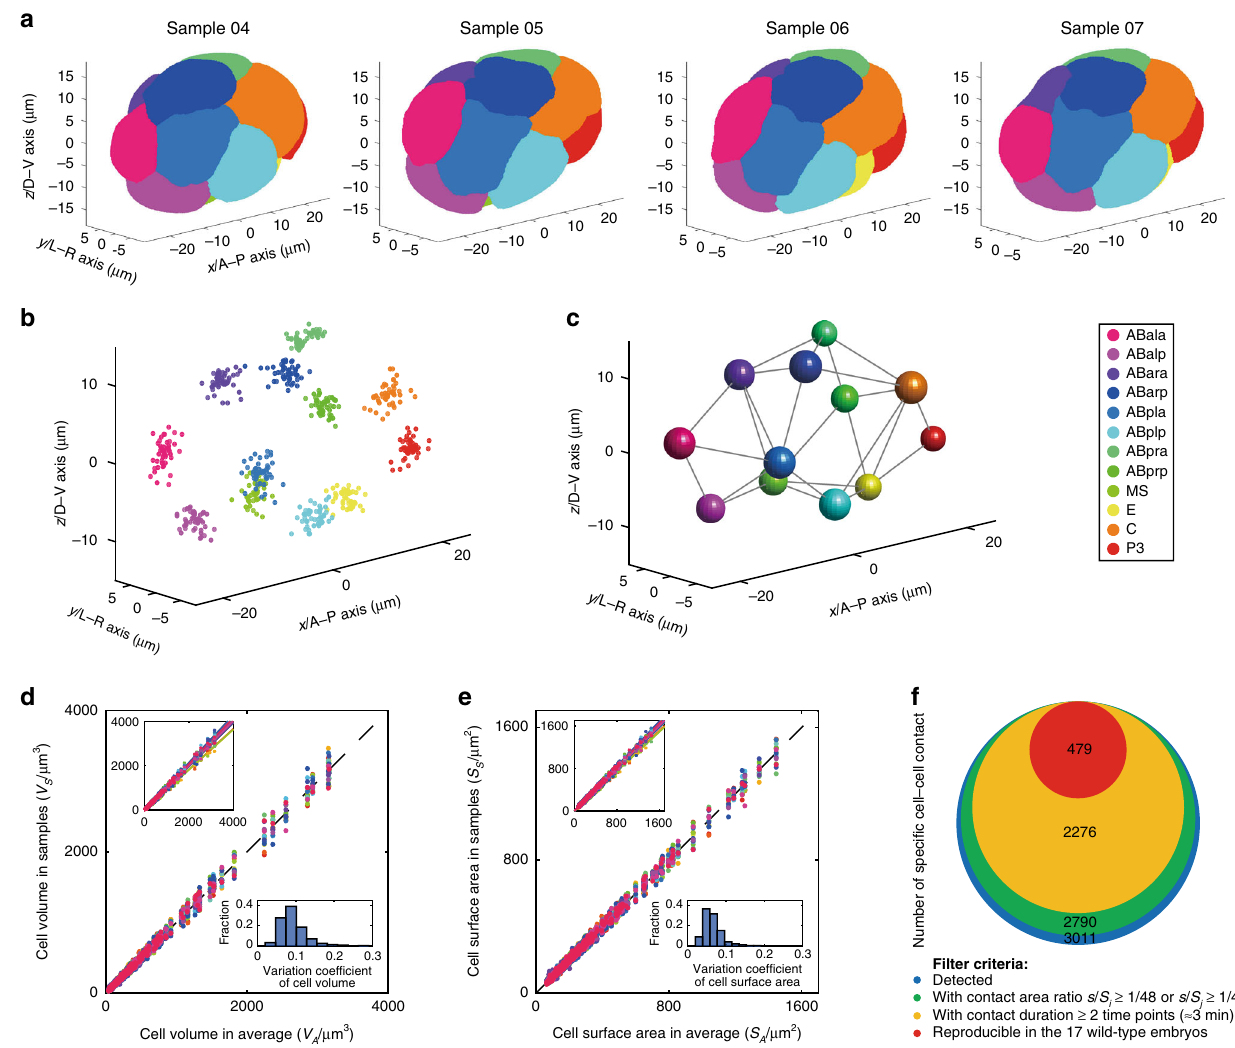
Fig. 3 A morphological atlas during C. elegans embryogenesis. a – c Different dimensions of a standardized spatiotemporal reference, illustrated using the 12-cell stage as an example. The x, y , and z axes represent the anterior – posterior (A – P), left – right (L – R), and dorsal – ventral (D – V) axes, respectively, and each color denotes one speci fi c blast cell as indicated. a 3D representations of four wild-type embryos reconstructed with membrane label (Samples 04 – 07). b Spatial distribution of cell position (nuclei) of 46 embryos (Samples 04 – 49). c Cellular spatial deviation and reproducible cell – cell contact mapping. The sphere radius represents spatial deviation Δ r de fi ned by the root-mean-square deviation (RMSD, Δ r ¼ the total number of embryos and r i denotes the cell position in the i th embryo). Each gray line represents reproducible and effective contact between cells under speci fi c fi lter criteria: s contact / S surface ≥ 1/48, T contact ≥ 3 min, N replicate = N embryo (see “ Methods ” ). d , e Reproducibility and variability of cell volume and cell surface area, tested using proportionally normalized data from all 322 cells with a complete lifespan (Supplementary Data 3). Each color represents an individual embryo. Top-left insets: data graphed using original data prior to normalization. Bottom-right insets: variation coef fi cients of each cell among the 17 embryos using the normalized data. f Criteria for de fi ning effective cell – cell contact (red). The whole pool of cell – cell contacts detected and the ones fi ltered out through different criteria are symbolized by circles with different areas and colors. Source data are provided as a Source Data fi